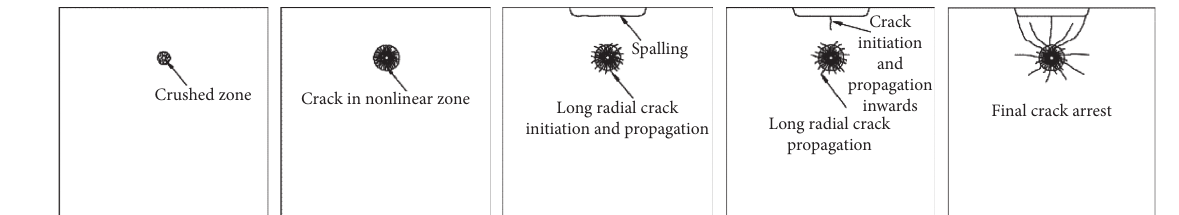
Figure 8: Rock blasting failure pattern under stress wave action with one free